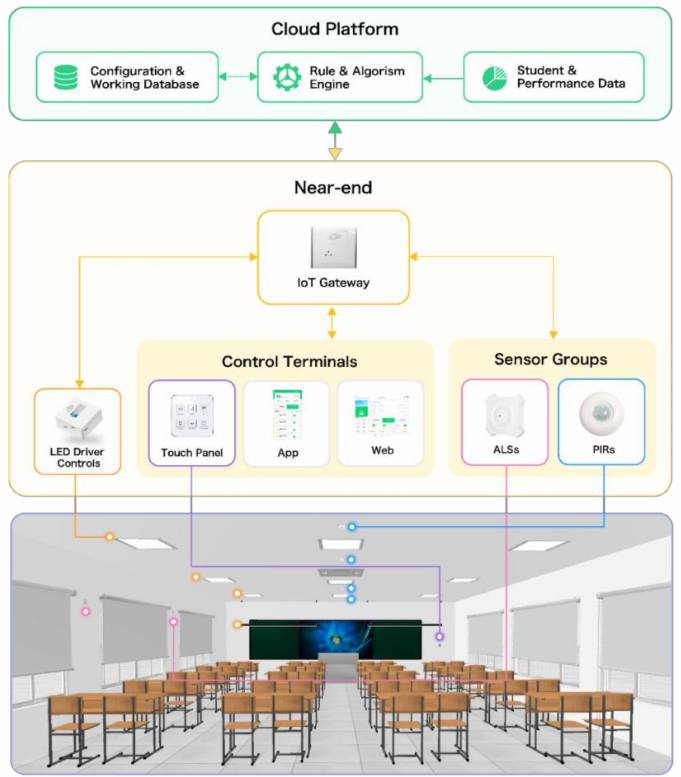
Figure 2. Structure of learning-context-based smart lighting system. ALS: Ambient light sensor; PIR: Passive infrared sensor.